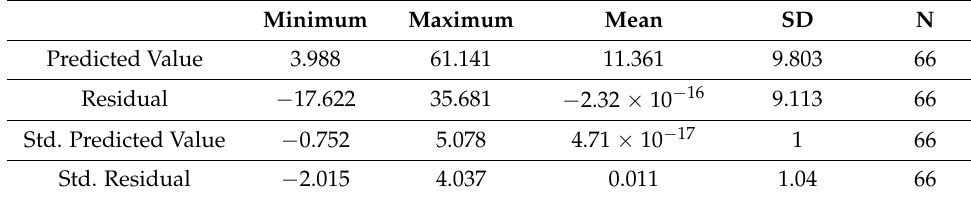
Table 8. Vertical dry plate method and wet candle method—statistic of residuals.